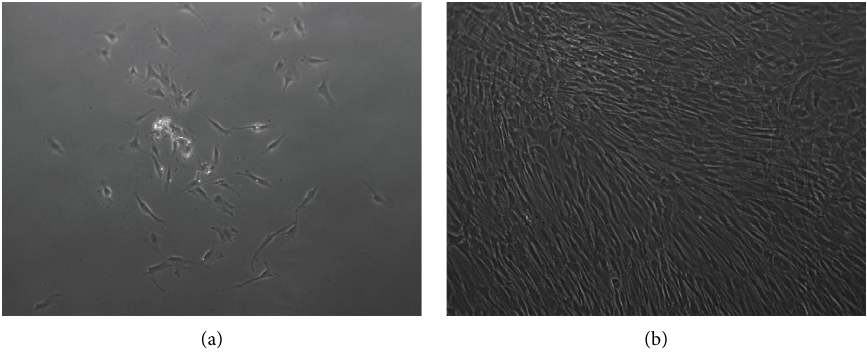
Figure 1: Isolation and culture of SCAPs. First attachment at fourth day (a) and full confuency at eighteenth day